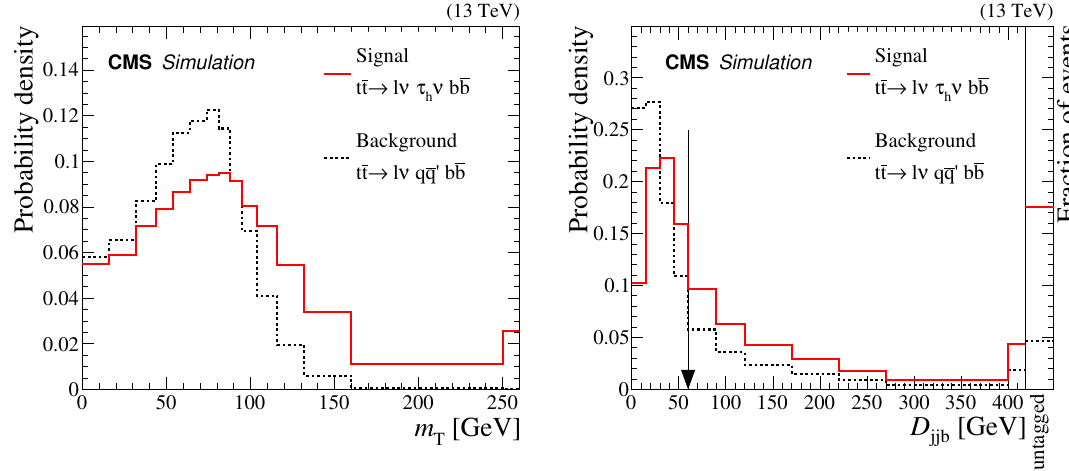
Figure 2. Comparison of the signal (tt ! ‘(cid:23) (cid:23) bb) and the main background of misidenti(cid:12)ed t ‘ t h t (tt ! ‘(cid:23) qq 0 bb) in the shapes of the normalized distributions of the transverse mass m ‘ the lepton and p miss (left), and the D min parameter (see text) of the event categories (right). In T jjb the m distribution, the signal may extend beyond the W boson mass endpoint because of the T two-neutrino (cid:12)nal state, whereas the background process cannot. The last bin in both distributions includes over(cid:13)ow events. In the D min distribution, the downward arrow points at the threshold jjb of the cut used ( D min > 60 GeV), and the panel on the right shows the fraction of events in the jjb \signal-like" category where there is only one untagged jet, which amounts to approximately 5% of all background events and 17% of all signal